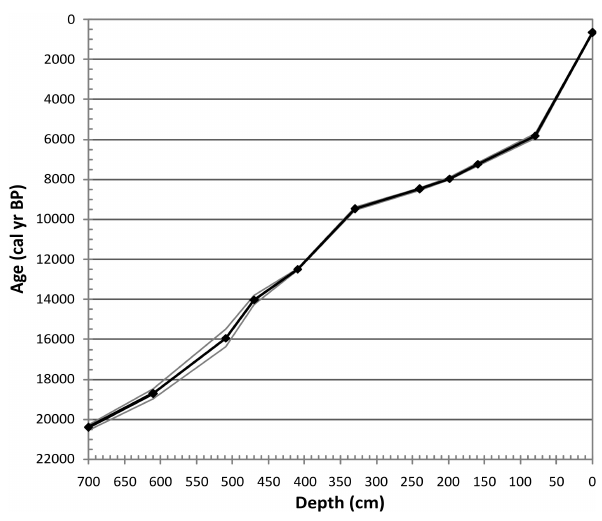
Fig. 2. Age–depth model for core MD04-2797CQ. Grey lines indi- cate the 1 σ error